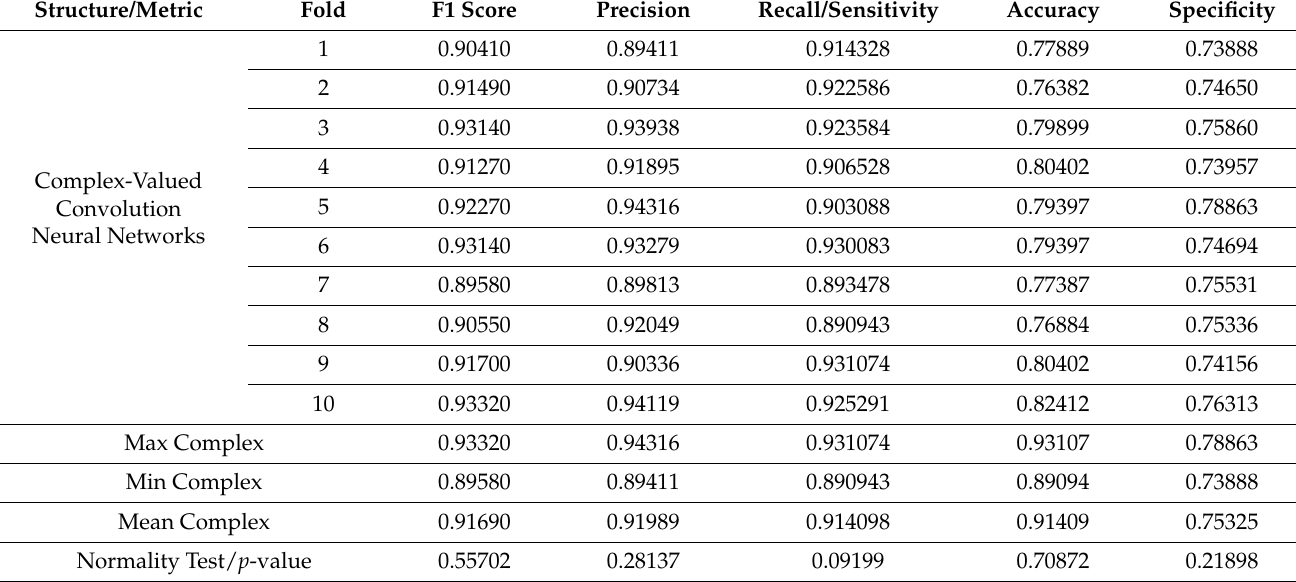
Table 6. Results obtained with the complex-valued convolution network studied for the ISIC2017 dataset.